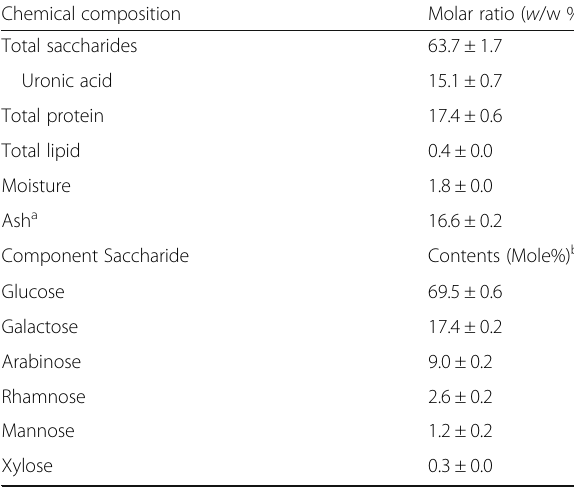
Table 1 Chemical composition of ISAg and its major